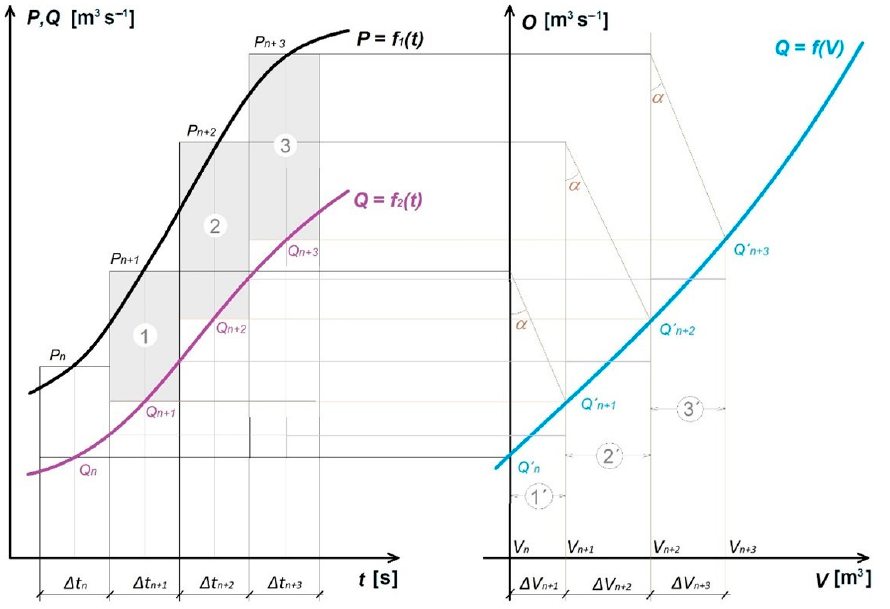
Figure 3. Principle of the Klemeš graphical method [43].